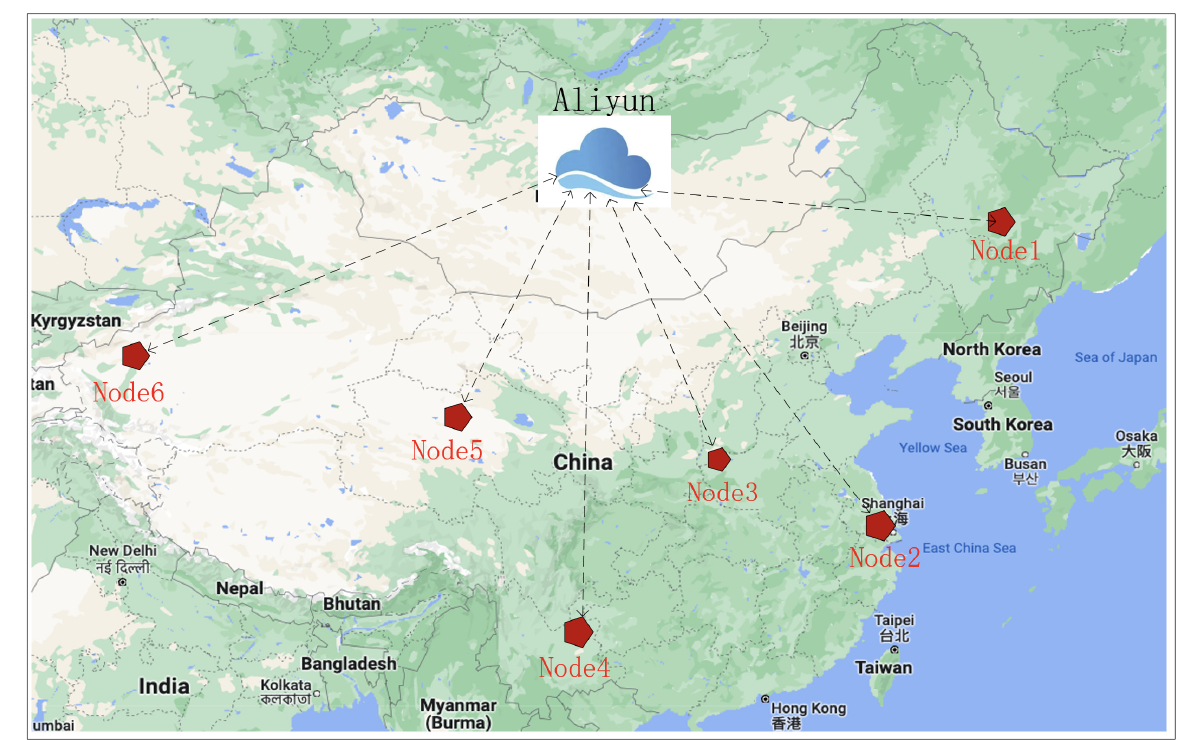
Figure 7. Cloud computing structure.